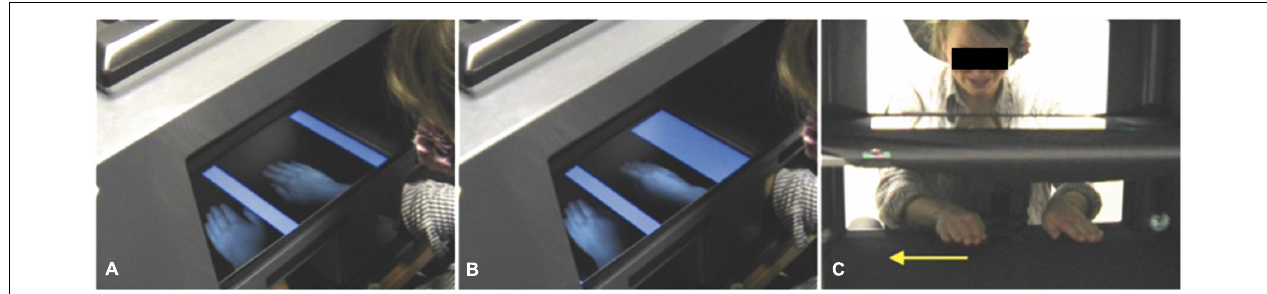
FIGURE 1 | (A) At the start of the adaptation procedure, the seen location of the right hand matches its real location (note the alignment of the seen right hand and participant’s real arm). (B) Over the course of the adaptation procedure, the superimposed blue bars slowly expand to constrict the hand space. At the same time and without the participant’s awareness, the image of the right hand is shifted slowly leftwards so that in order to keep the hand visible between the blue bars, the participant must move their hand rightwards. This results in a separation between the seen and real location of the right hand (note the misalignment of the seen right hand and the participant’s real arm). In the actual experiment, a bib occluded the participant’s view of their arms. (C) The MIRAGE worksurface and participant’s hands from the experimenter’s viewpoint. The yellow arrow indicates the direction in which the right hand moves during the adaptation procedure. See electronic Supplementary Material 1 of Bellan et al. (2015) for a video of the MIRAGE adaptation procedure (incongruent